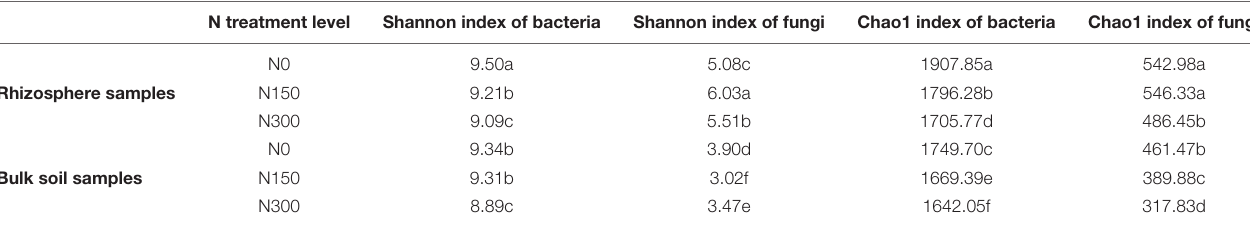
TABLE 1 | The diversity and richness of bacterial and fungal communities in rhizosphere and bulk soil samples subjected to three levels of nitrogen (N) fertilization, characterized by Shannon and Chao1 indices according to alpha diversity analysis. N treatment level Shannon index of